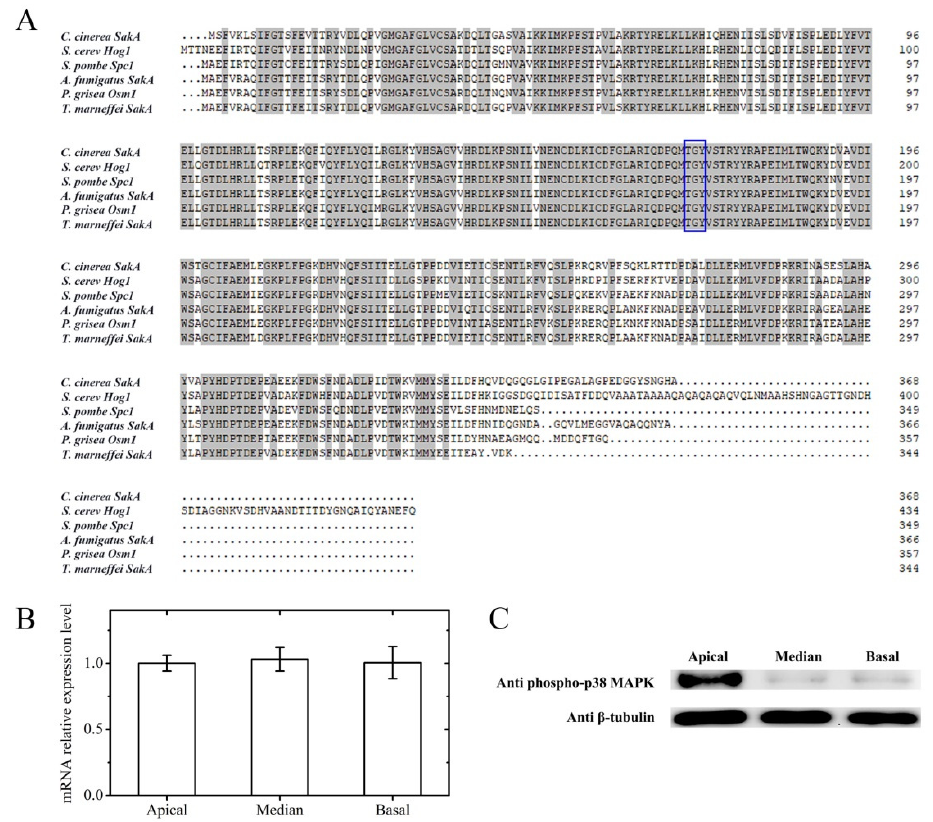
Figure 1. ( A ) The CcsakA gene encodes a putative homologue of the MAPK of the HOG pathway in C. cinerea . The amino acid sequence of CcSakA is aligned with S. cerevisiae Hog1 [40], S. pombe Spc1 [41], A. fumigatus SakA [39], P. grisea Osm1 [42], and T. marneffei SakA [43]. Conserved TGY phosphorylation sites found in the stress Hog1/Spc1/p38 MAPK family are marked with blue boxes. ( B ) The relative mRNA expression level of sakA in the different stipe regions during the development of C. cinerea fruiting bodies. ( C ) Western blotting of the phosphorylation of CcSakA in the extracts from different stipe regions during the development of C. cinerea fruiting bodies. Phosphorylated CcSakA was detected using anti-phospho-p38 MAPK antibody. Levels of β -tubulin were used to demonstrate equal protein loading.